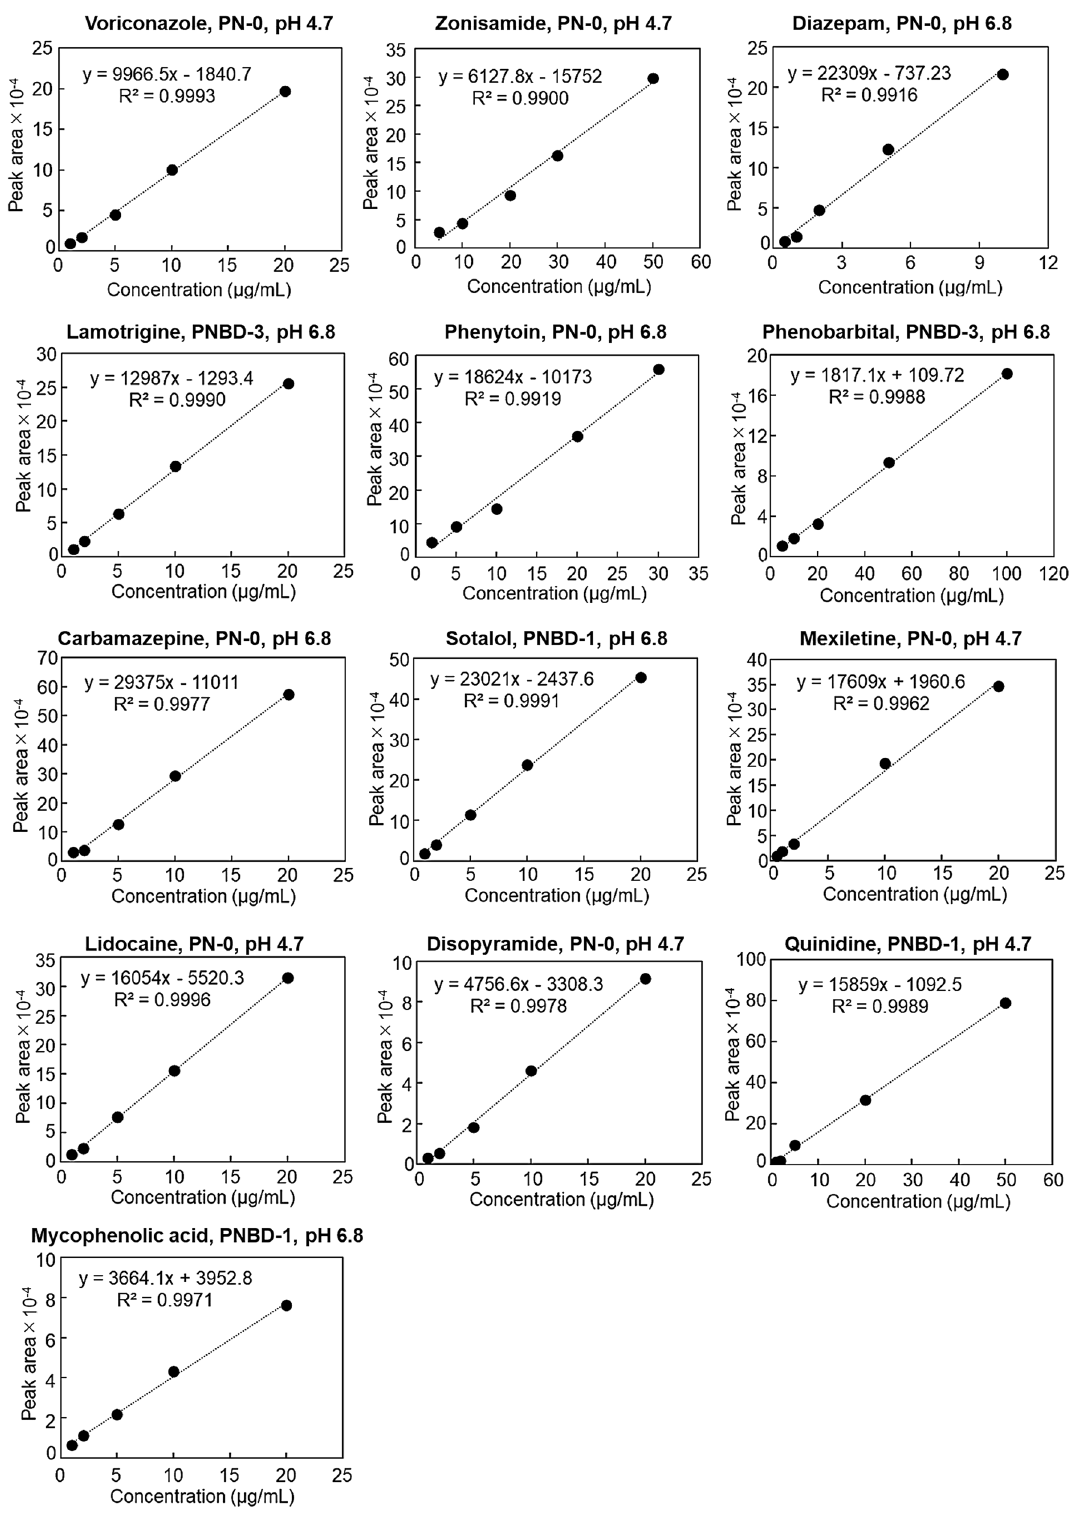
Figure 6. Calibration curves of the drugs with serum proteins ( n =